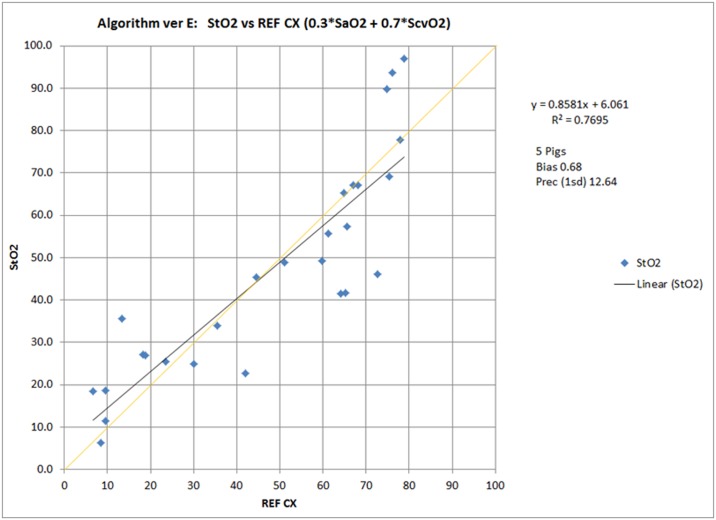
NIRS Validation Study.A Pearson correlation examining StO2 values and reference calculations from blood draws demonstrated a strong correlation between measured NIRS and actual oxygen saturation levels (R2 = 0.7695).